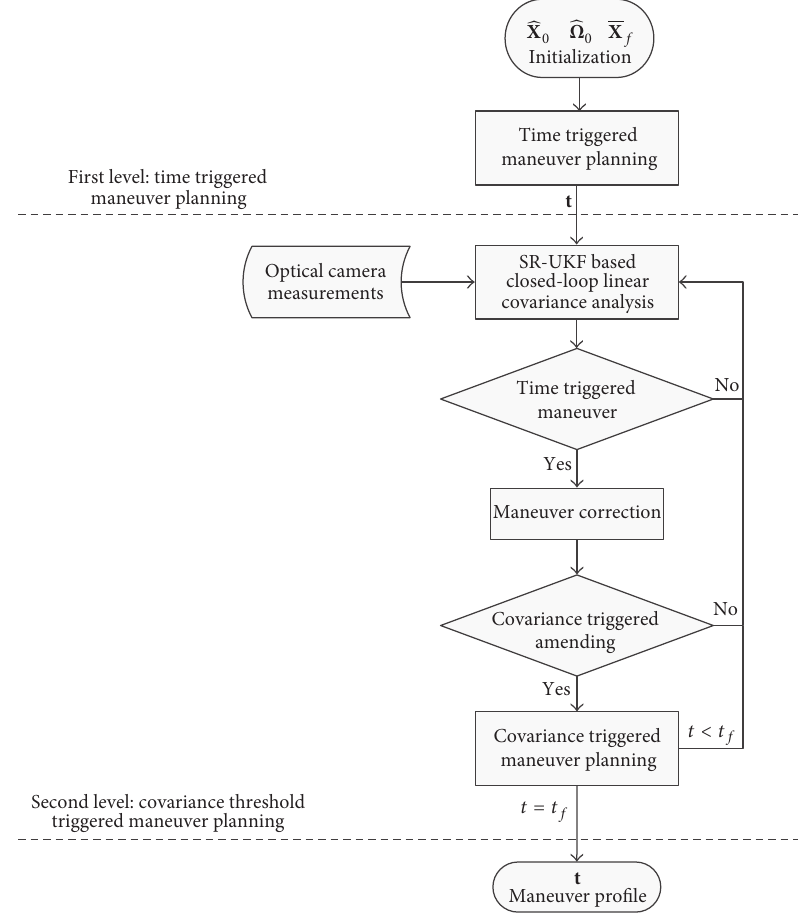
Figure 2: Chart flow of time and covariance threshold triggered maneuver